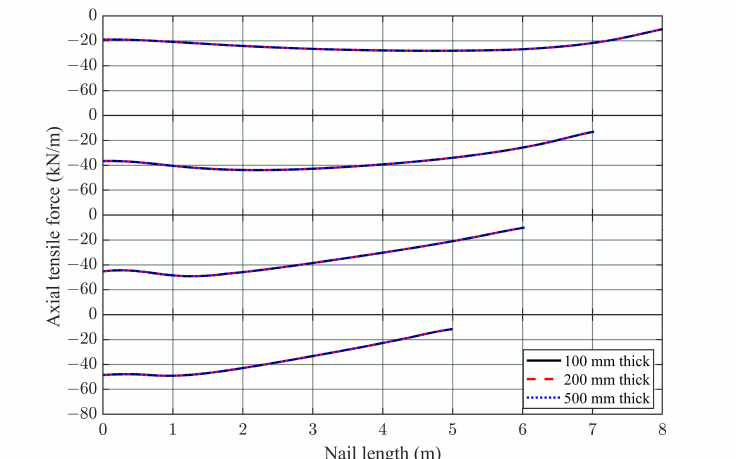
Figure 11. Distribution of nail axial force under nail heads of various